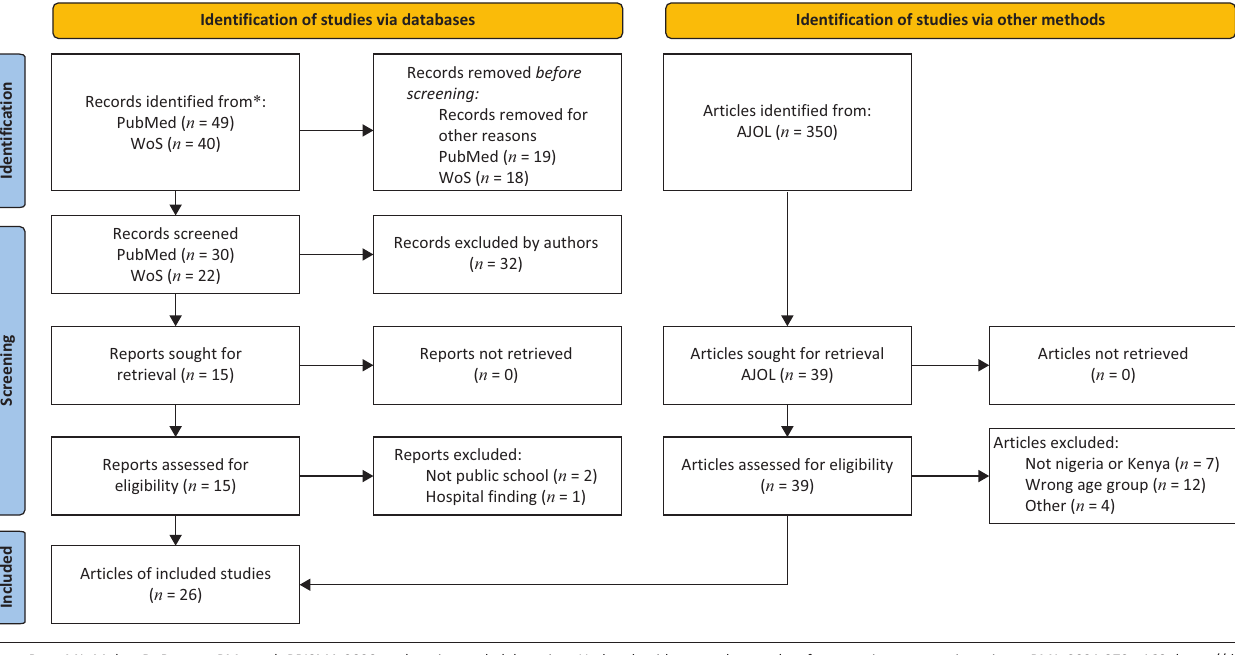
FIGURE 1: PRISMA flow-chart.